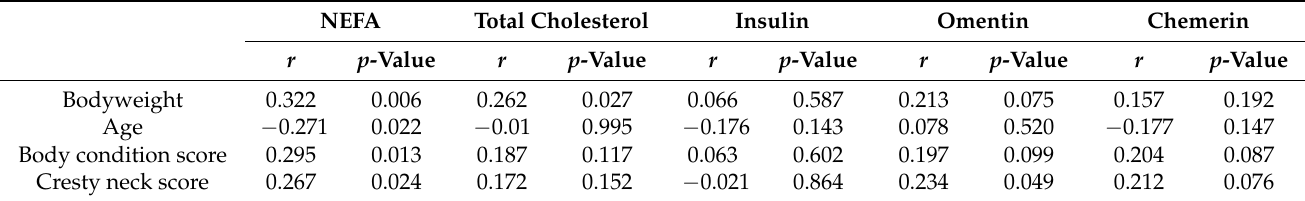
Table 3. Correlation of NEFA, total cholesterol, insulin, omentin, and chemerin levels with selected